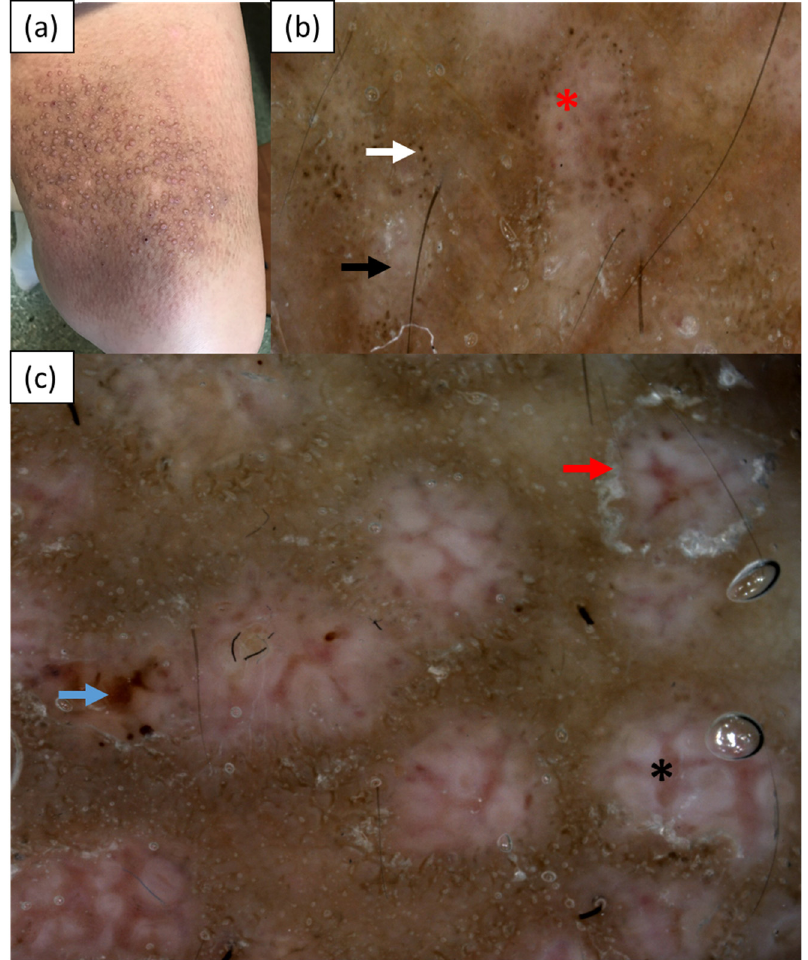
Figure 2. Case 2 — ( a ) hyperkeratotic brown papules on the extensor surface of the left thigh; ( b , c ) videodermoscopy (Canfield D200 EVO ) showing central white hubs (black arrow) with greyish-brown globules at the periphery (white arrow), erosion (blue arrow) and white collarette scaling (red arrow). Red globules (red asterisk) in the center of the white hub and thick, unfocused branching vessels intersecting the white hubs (black asterisk) are present.